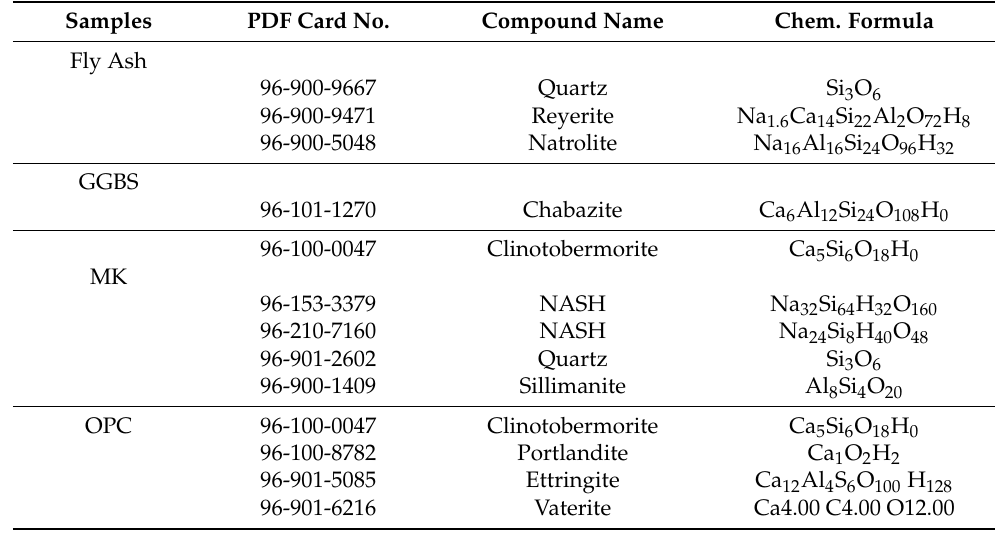
Table 6. Compound Name and Chemical Formula used in the XRD.